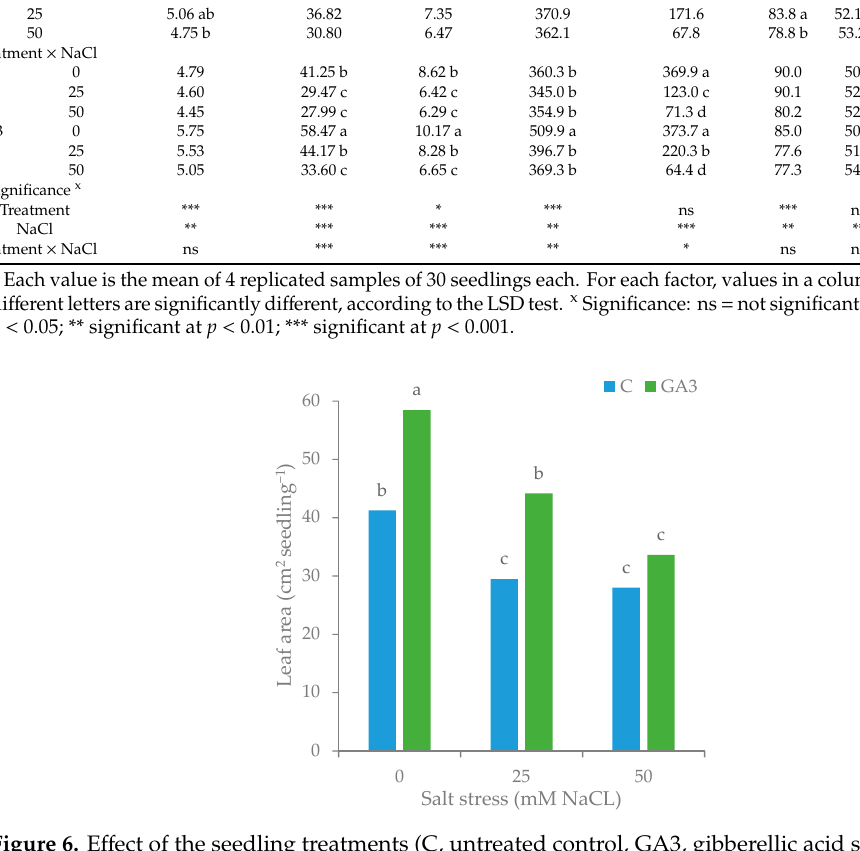
Figure 6. Effect of the seedling treatments (C, untreated control, GA3, gibberellic acid spray 10 − 5 M) and the salt stress (0, 25, and 50 mM NaCl in the irrigation water) on the total leaf area of tomato seedlings. Bars with different letters are significantly different at p < 0.05 according to the LSD test.